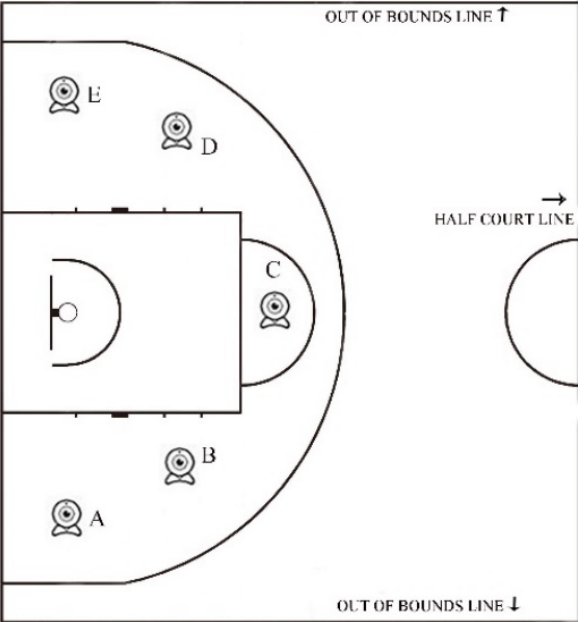
Figure 3. The positions of cameras on the basketball court.